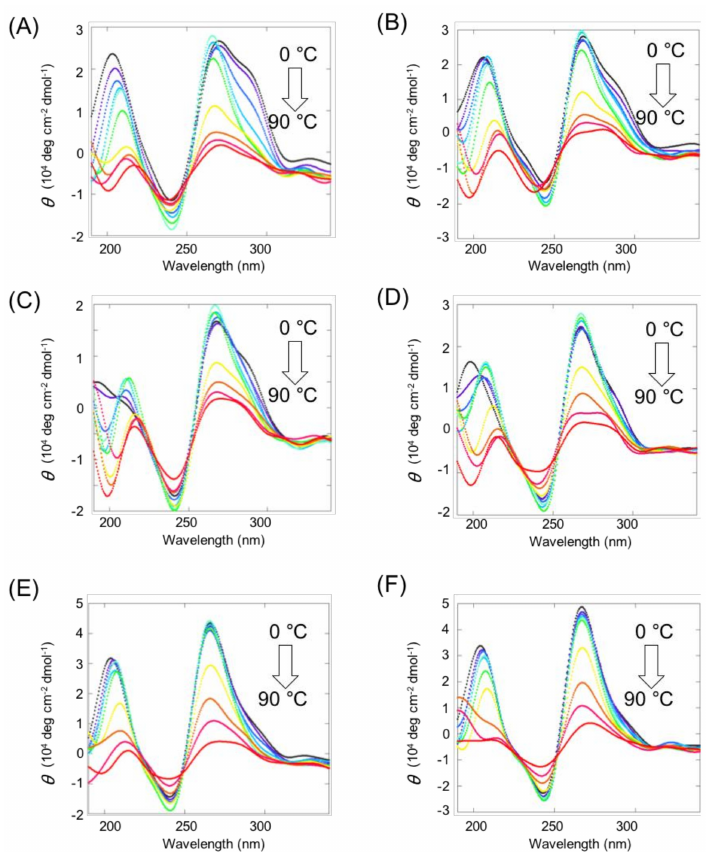
Figure 3. Circular dichroism (CD) spectra of 10 µ M VEGF G2T with 10 µ M ( A ) PySG 3 , ( B ) G 3 PyS, ( C ) PyLG 3 , ( D ) G 3 PyL, ( E ) PEPyG 3 , and ( F ) G 3 PEPy. All measurements were conducted in a buffer consisting of 10 mM Tris-HCl (pH 7.5), 8 mM MgCl 2 , and 50 mM